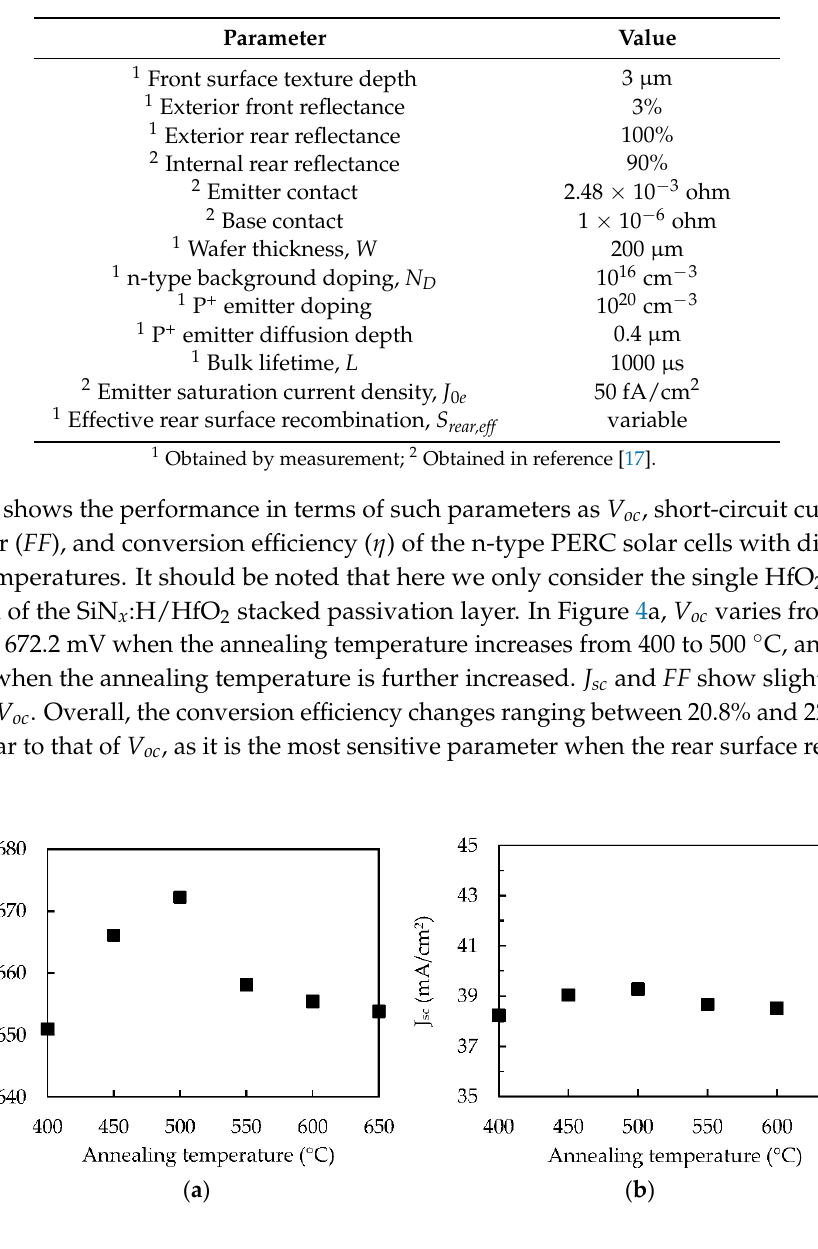
Table 2. Simulation parameters for n-type passivated emitter and rear contact (PERC) solar cells with an HfO 2 passivation layer.